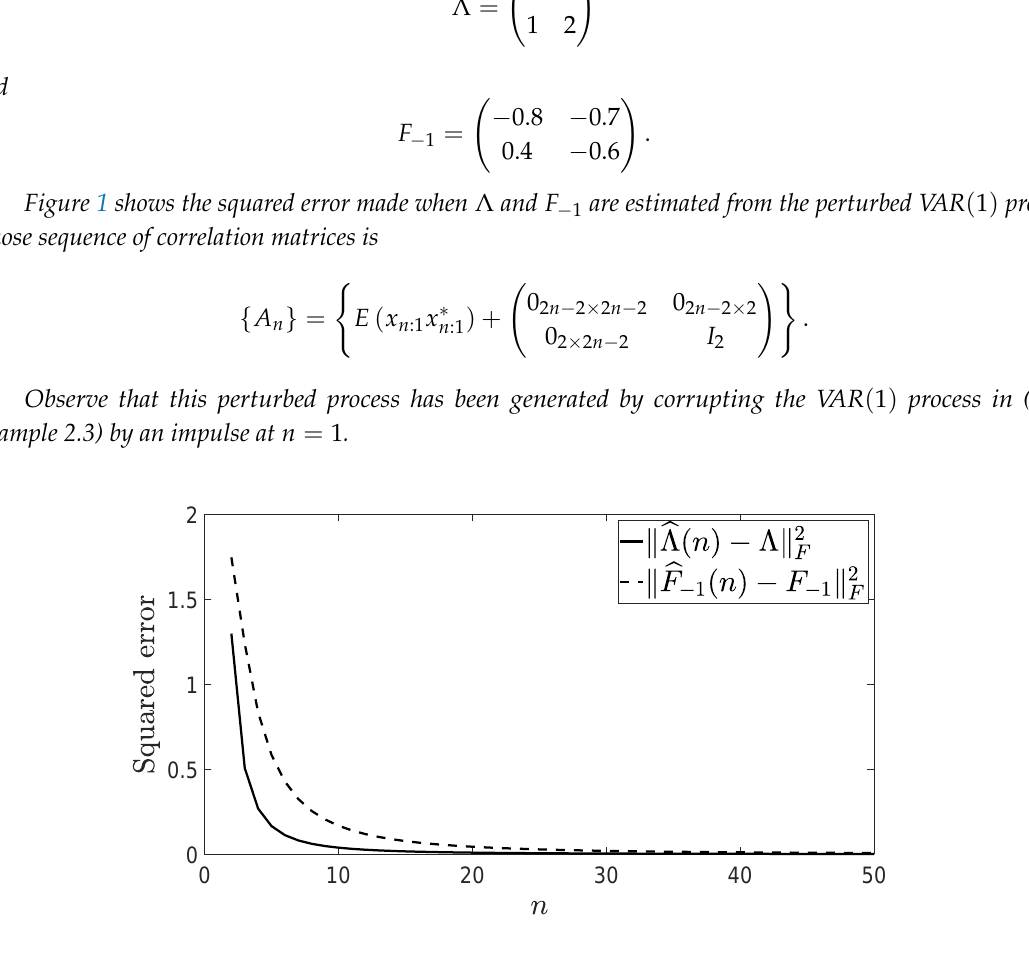
Figure 1. Squared error made when Λ and F − 1 are estimated by (cid:98) Λ ( n ) and (cid:98) F − 1 ( n ) ,